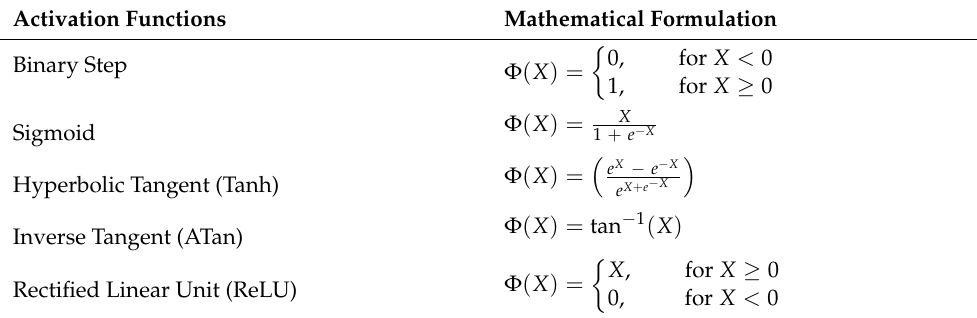
Table 2. The mathematical formulation of the considered activation